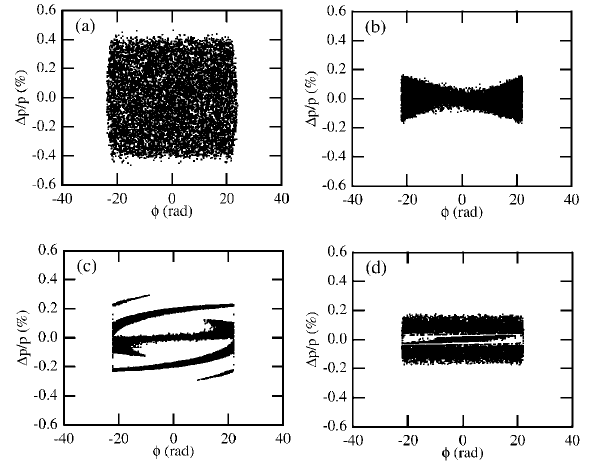
FIG. 9. Density distribution of a superbunch beam in the (cid:4) (cid:17) p=p direction at (a) injection, (b) 4.69 GeV, (c) 6.69 GeV, 0 (cid:4) 7 (cid:14) (rad) and k (cid:4) (cid:5) 0 : 43 (cid:1) kV =(cid:22) s (cid:2) and (d) 11.64 GeV. (cid:23) 0